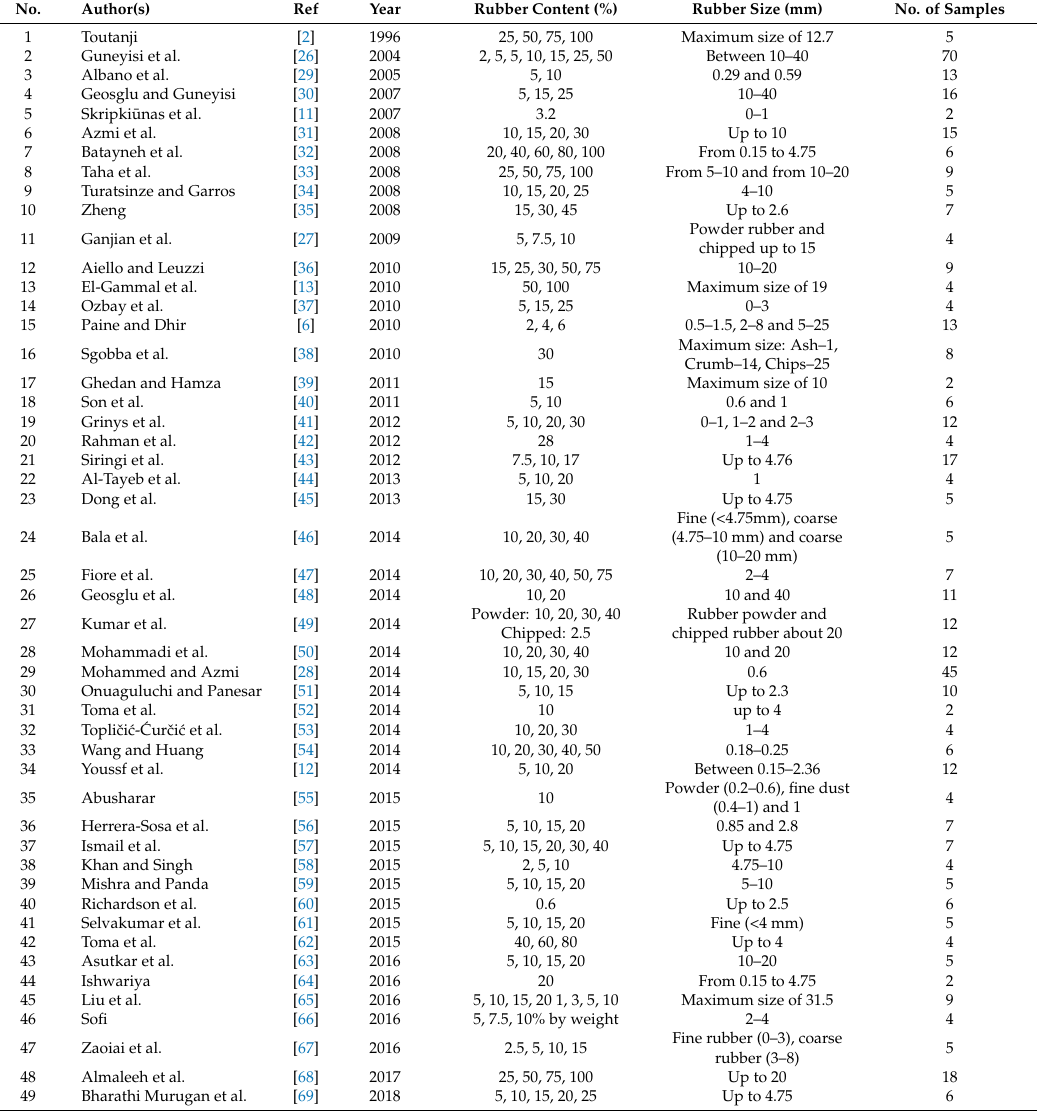
Table 1. Database of concrete with tire